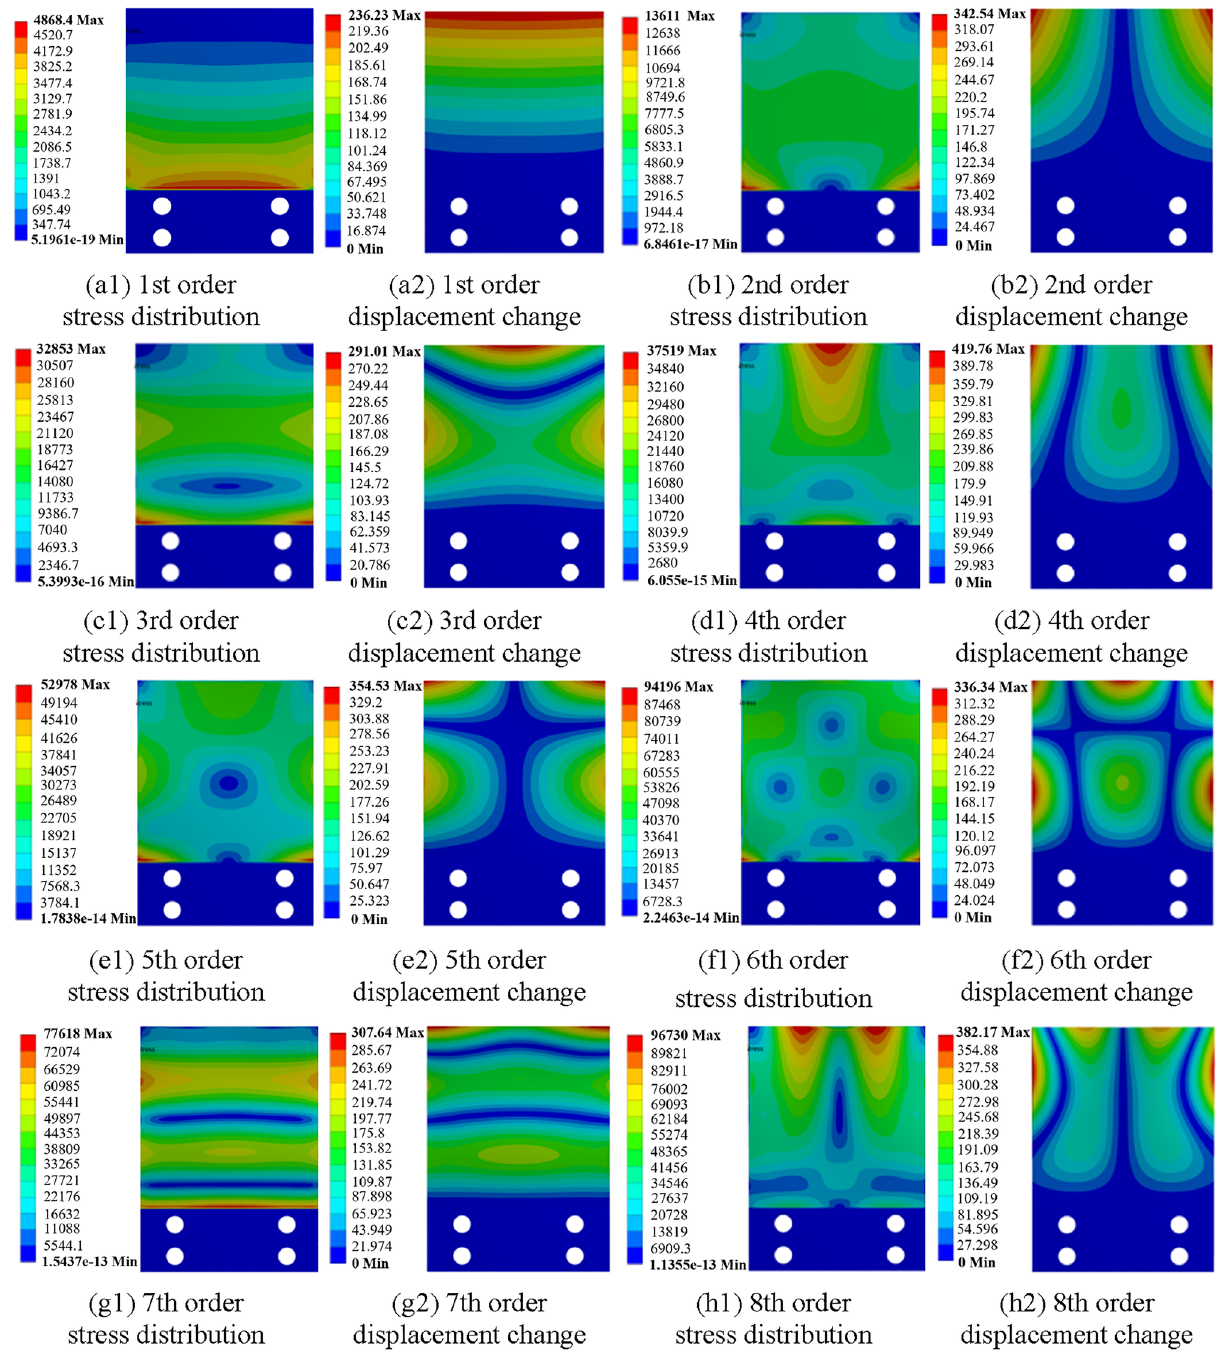
Figure 7. Stress distribution and displacement change of the specimen in each order mode (unit: MPa).